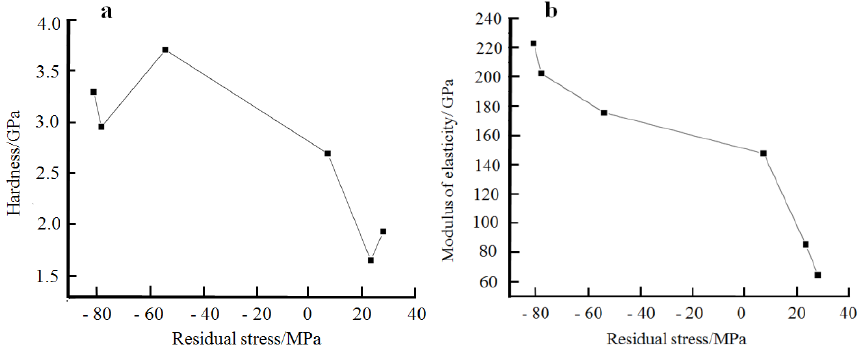
Figure 12. Curve of residual stress in the plating versus hardness and modulus of elasticity. ( a ) hardness, ( b ) Modulus of elasticity